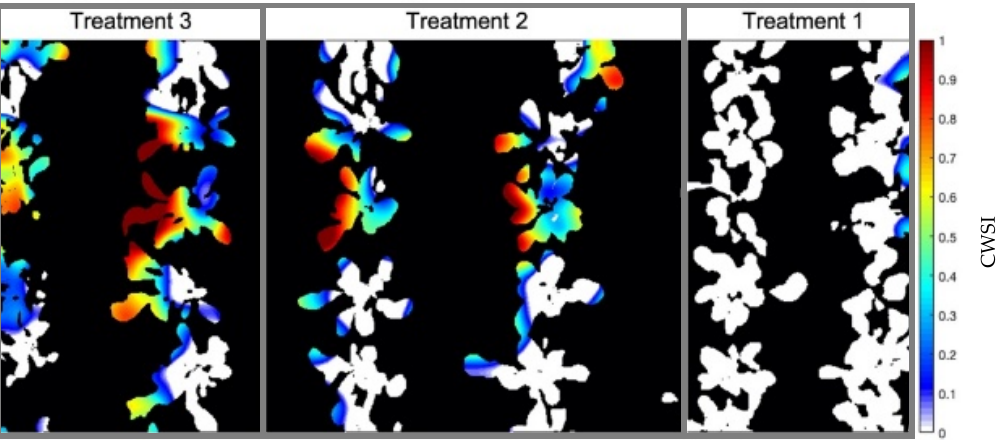
Figure 13. CWSI (Crop Water Stress Index) map of the experimental area in a protected environment generated for the 25DAP (Day After Planting), in a scan carried out at 12:00 p.m., the time with the best reading results. Treatment 1 (T 1 = 85% FC (Field Capacity)); Treatment 2 (T 2 = 75% FC); Treatment 3 (T 3 = 55% FC).